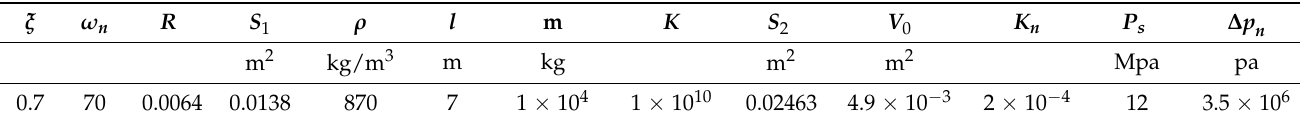
Table 1. The parameters values under the design condition.